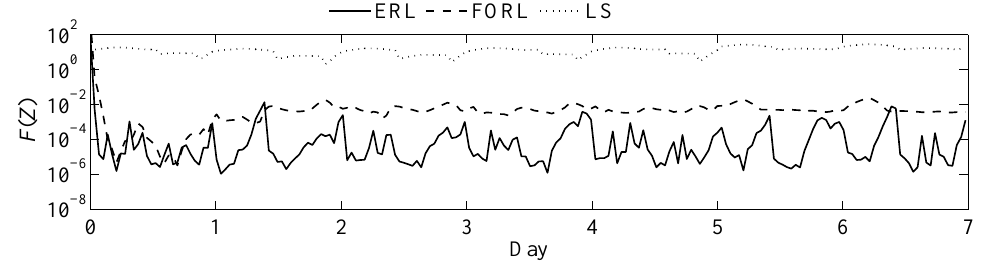
Figure 8. Error function values over seven days on the 1209-bus power